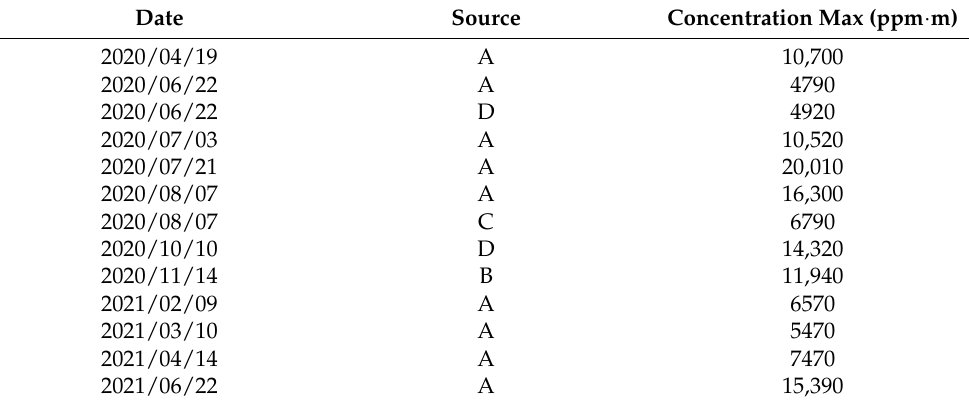
Table 3. Maximum concentration (in ppm · m) for each plume detected as a function of the source. Seven of the thirteen plumes have a maximum concentration above 10,000 pmm ·